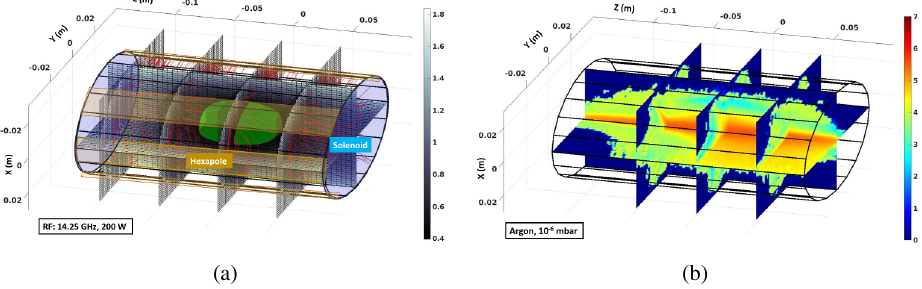
Figure 1: (a) 3D magnetostatic field profile of typical ECRIS with resonance surface (green shell) and associated field streamlines (red curves) generated using solenoid (blue) and hexapoles (yellow) and (b) 3D map of mean charge of Ar plasma when simulated till 8 + . Operating conditions like microwave frequency, power and gas pressure are mentioned in insets.